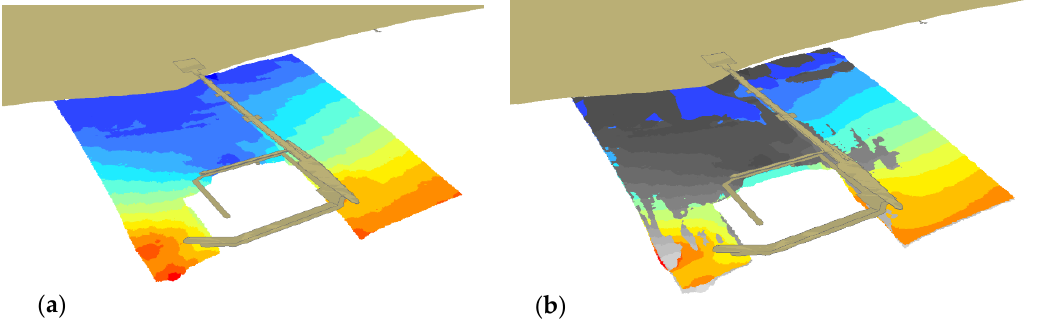
Figure 13. 3D bottom model based on the 2018 ( a ), 2012 and 2018 ( b ) SBES surveys.